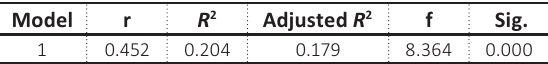
Table 8. Regressing intrapreneurship variable on